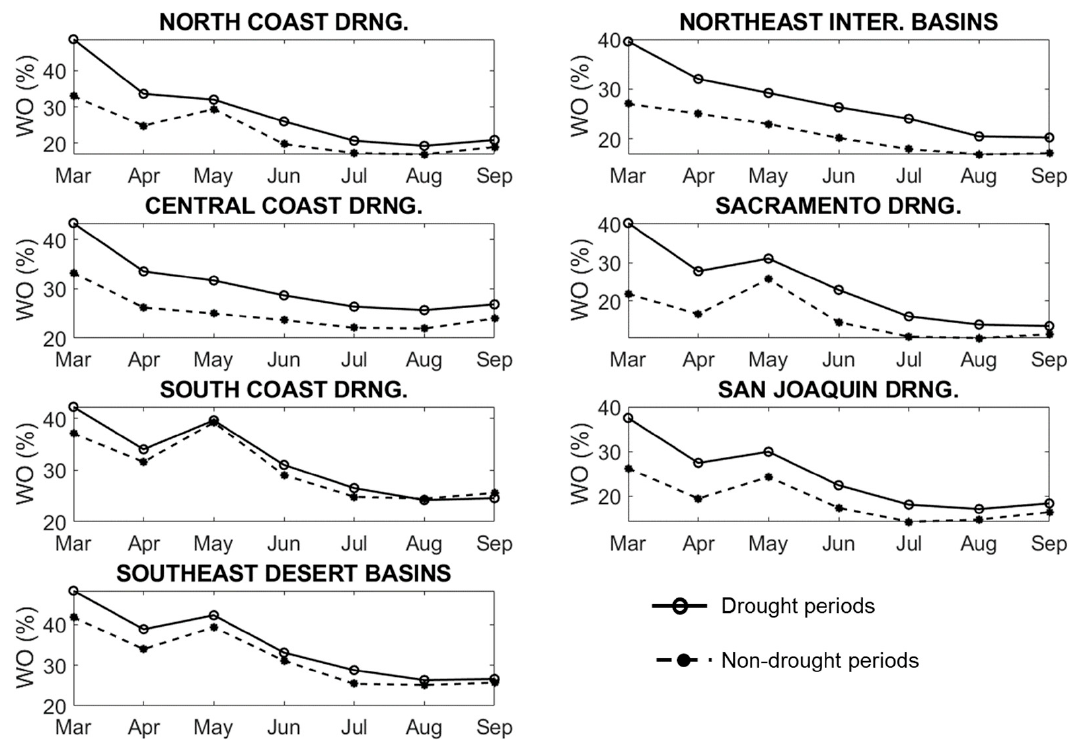
Figure 5. Mean river extent/area change during seasonal drying from March to September averaged over the drought and non-drought periods.